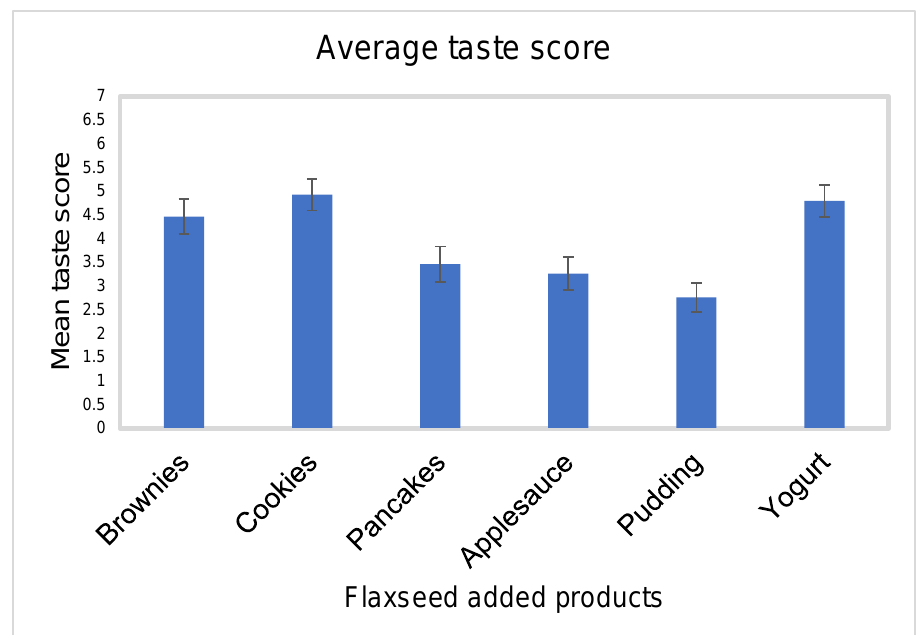
Figure 3. Mean score with SEM for taste for all flaxseed products.